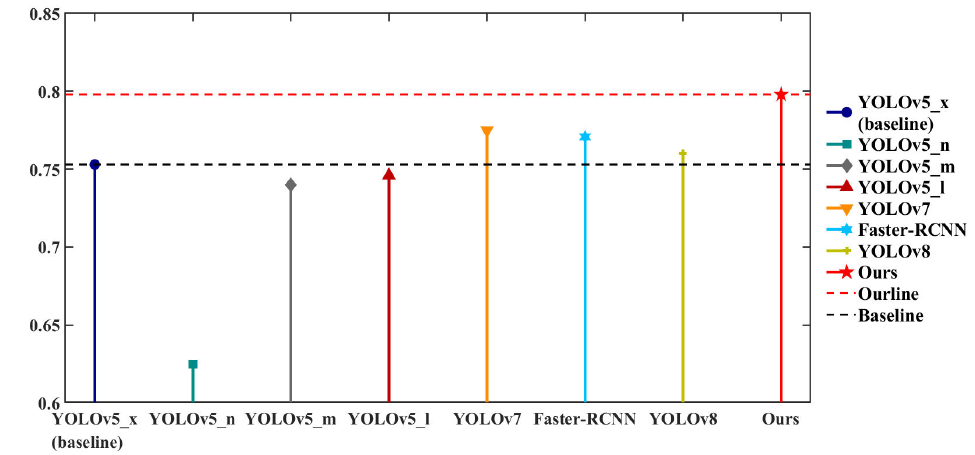
Figure 18. Visualization of comparative experiments based on URPC2019 dataset. Table 3. Comparative experiments based on the URPC2020 dataset.